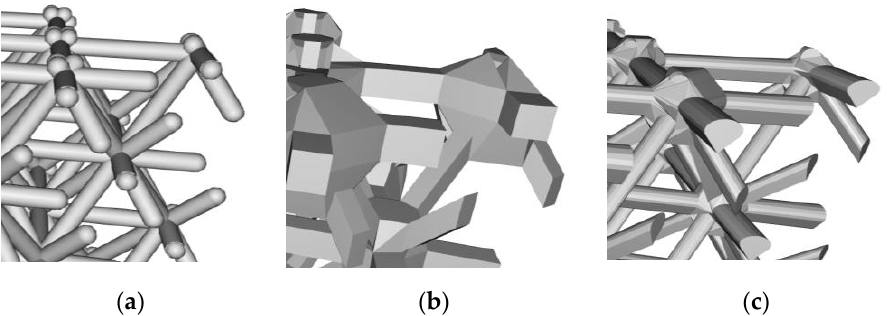
Figure 6. Different cross-sections for the beams that constitute the lattice: ( a ) circular section, ( b ) square section, and ( c ) teardrop shape to aid in self-supporting overhangs.